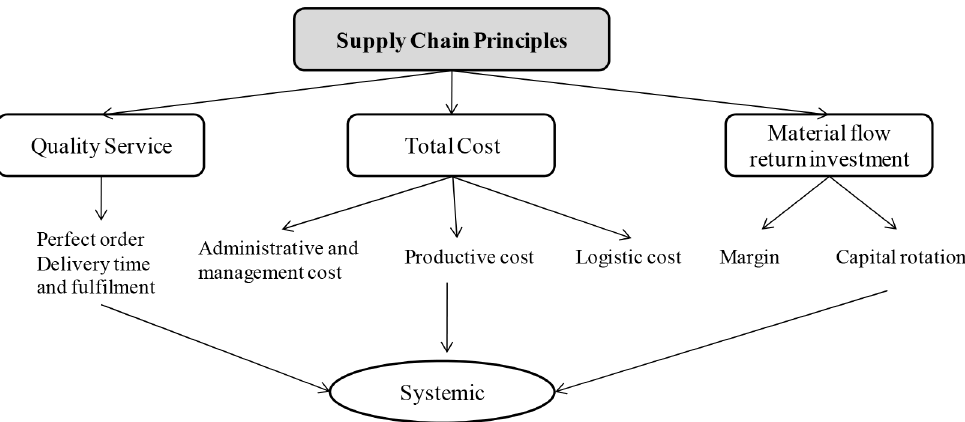
Figure 1. Supply chain principles (Errasti,